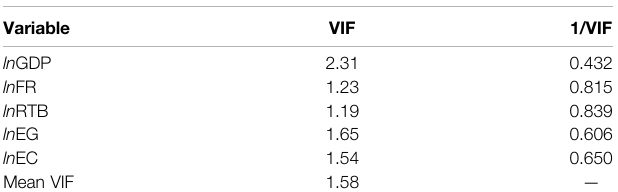
TABLE 3 | VIF test results.